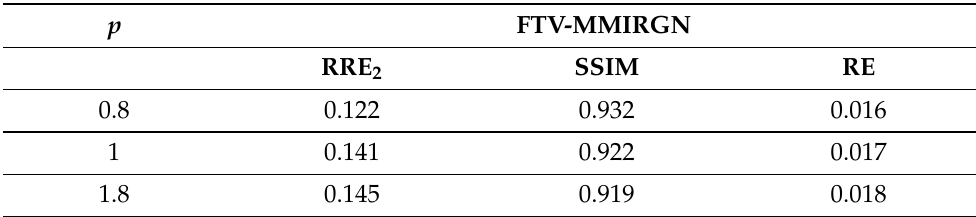
Table 3. Figures of merit (relative reconstruction errors for (cid:96) 2 norm, residual errors, and structural similarity) for Example